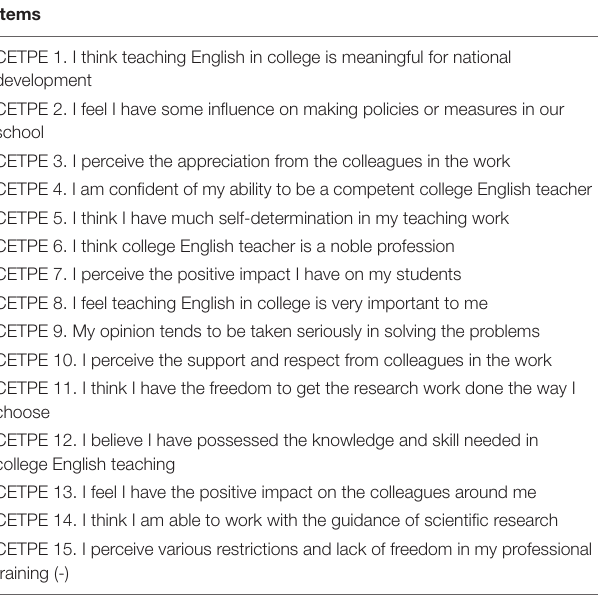
TABLE 7 | The formal CETPE scale (translated from the Chinese version). Items